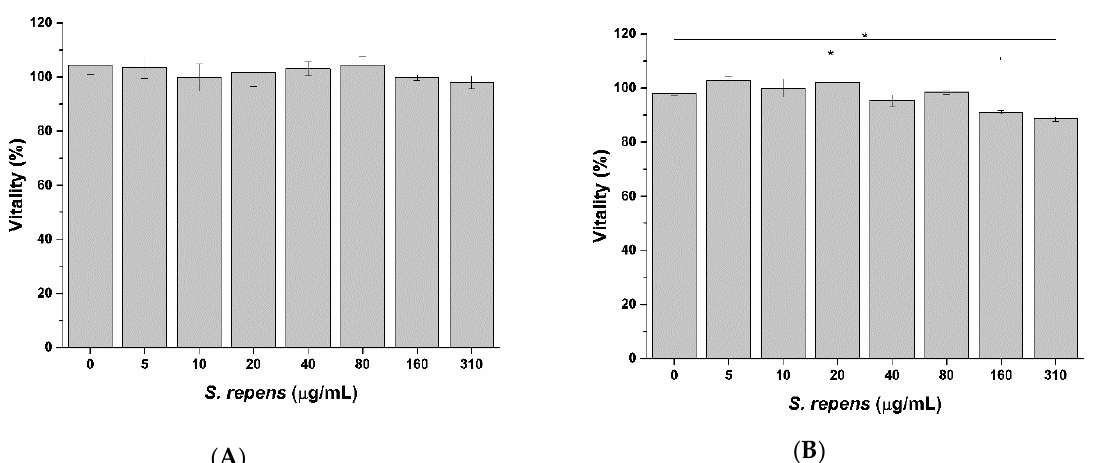
Figure 18. Effect on LNCaP prostatic cells vitality after 6 h ( A ) and 24 h ( B ) exposure to SRO. * p < 0.05 ( n = 3).